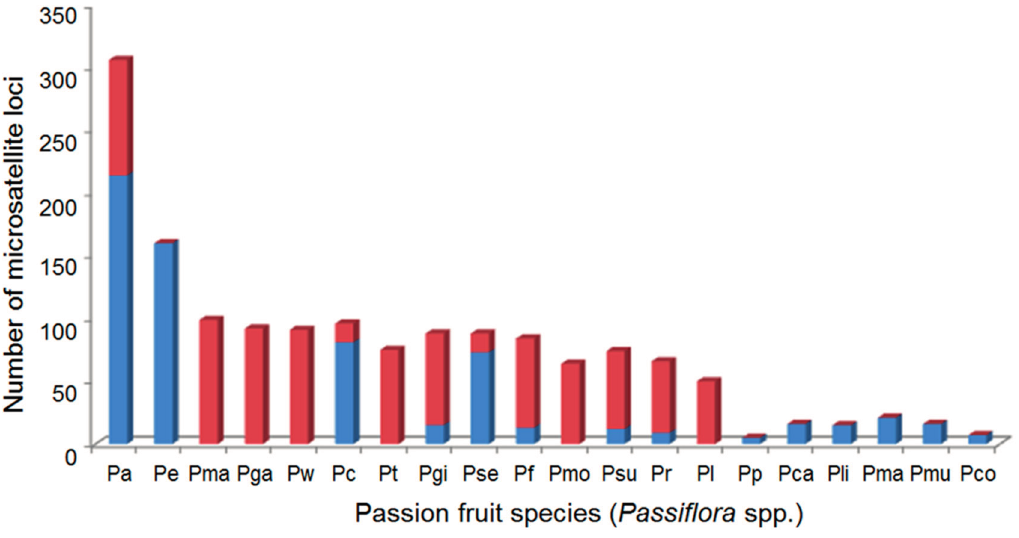
Figure 1. Microsatellite markers available for Passiflora species, including markers characterized in this study (red columns) and in previously published studies (blue